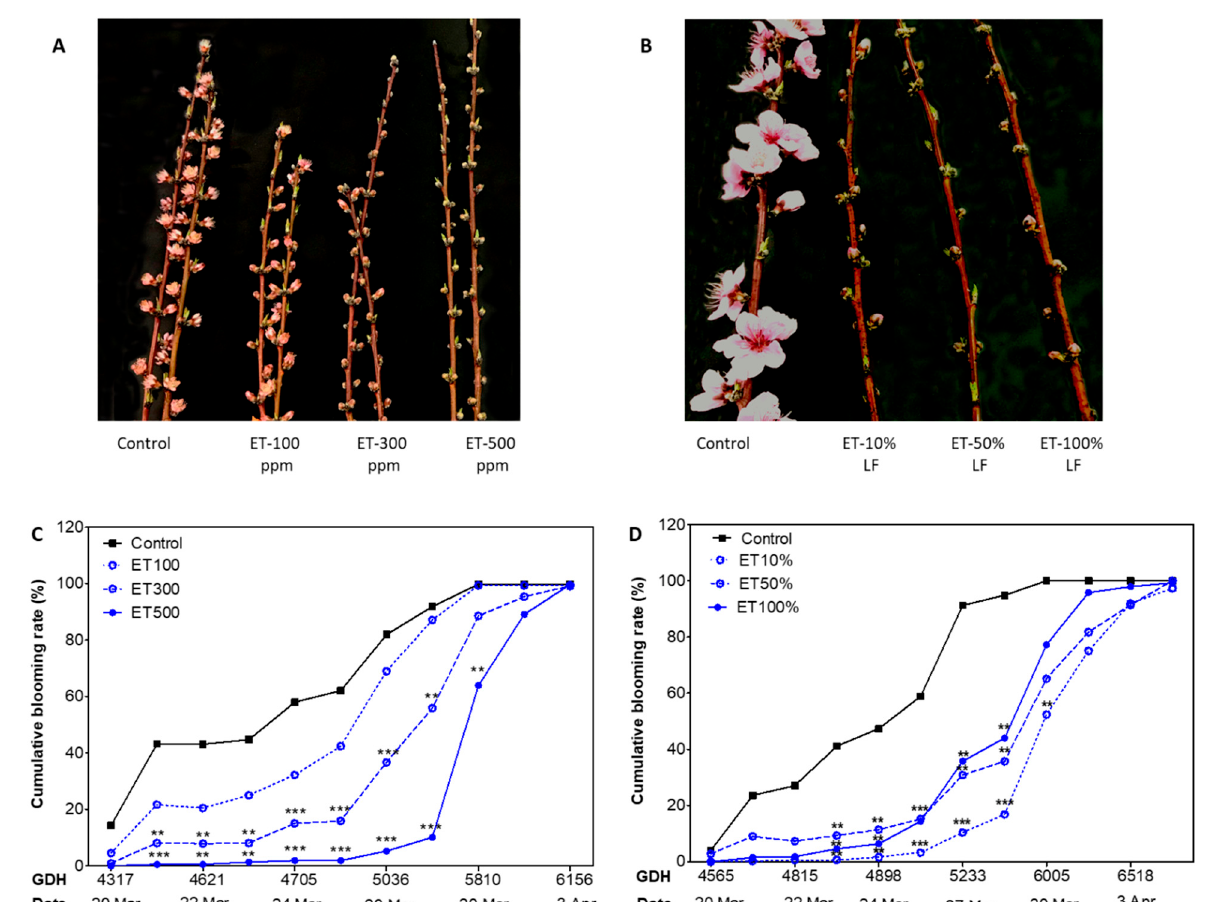
Figure 4. Bloom-delaying effects of ethephon (ET) on peach cultivars. Comparison of blooming between the untreated controls and ethephon treatments of ‘Redhaven’ ( A ) and ‘Sunhigh’ ( B ), with photos taken at full bloom of the controls (24 March 2020). Blooming progression of ‘Redhaven’ ( C ) and ‘Sunhigh’ ( D ) as affected by ethephon, and blooming rate calculated as the ratio of number of flowers to the number of buds on tagged branches. Each point represents the mean of size n = 12. Asterisks ** and *** indicate significant difference between ET treatments and the control at p < 0.01 and 0.001, respectively. ET, ethephon; LF, leaf fall.